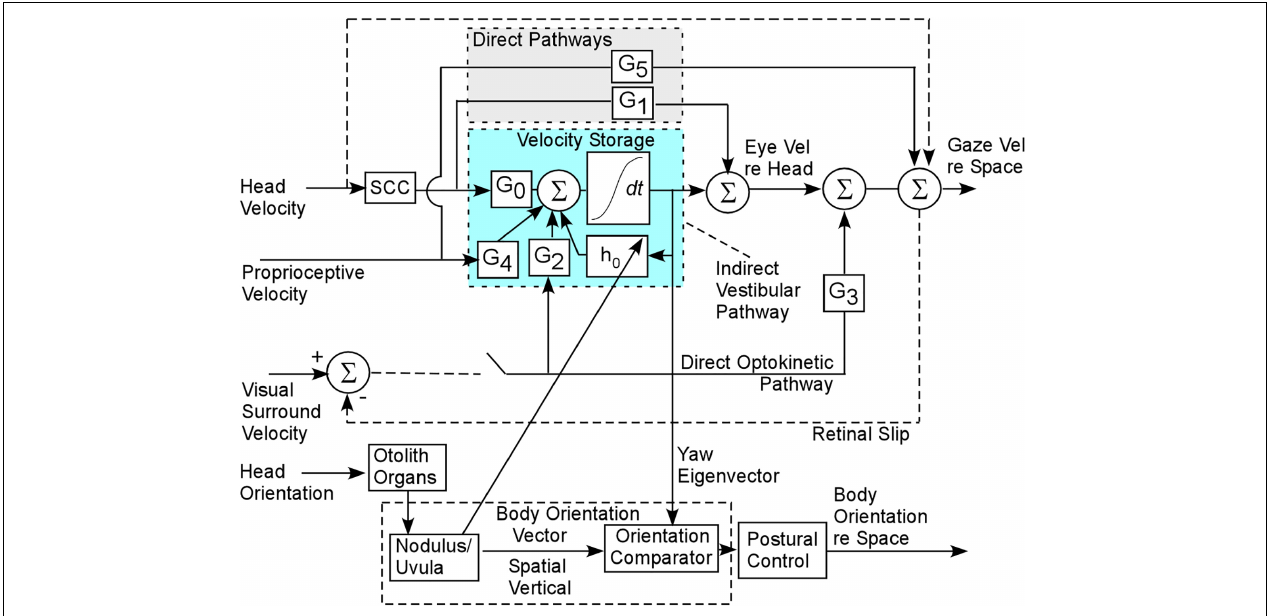
FIGURE 3 | Gaze and body postural control contributed by the velocity storage integrator. G 0 is the gain coupling matrix from the semicircular canals (SCC) to velocity storage. G 2 is the gain matrix coupling the optokinetic velocity input to velocity storage. G 4 is the gain coupling matrix from the proprioceptive velocity input to velocity storage. G 1 and G 3 are the direct pathway gain matrices from the semicircular canals and optokinetic input and are responsible for the rapid responses to head and optokinetic movement. There is also a rapid proprioceptive pathway (G 5 ), but these are assumed not to play a role in the maladaptation leading to